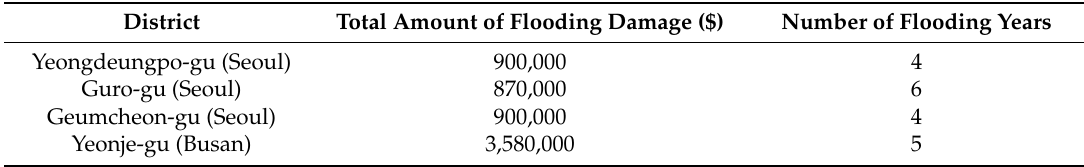
District Total Amount of Flooding Damage ($) Number of Flooding